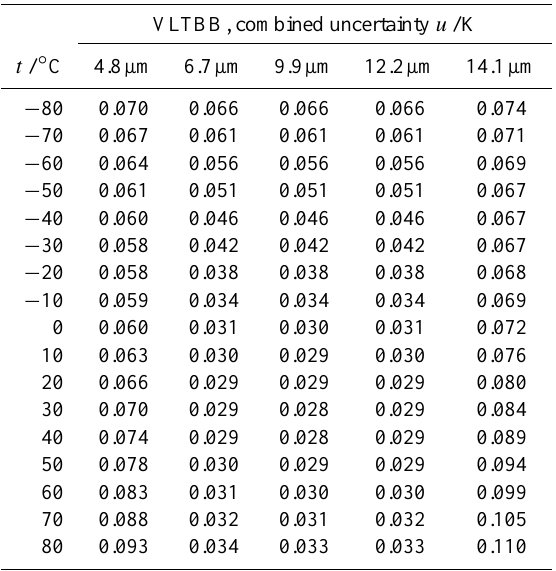
Fig. 9. Comparisons of the VLTBB with other radiation temperature standards in the context of the radiometric calibration of the GLORIA blackbodies.